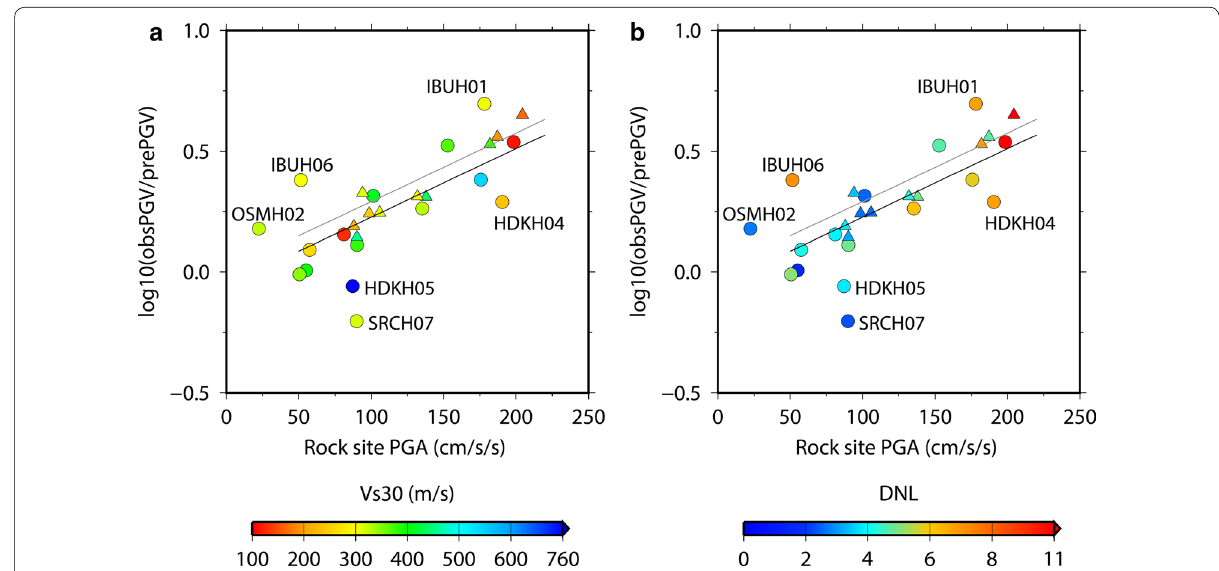
Fig. 16 Plots of logarithmic residuals for PGVs as a function of rock site PGAs using the GMPEs in Si and Midorikawa (1999). The data are color-coded by Vs30 values in a and DNL values in b , respectively. The KiK-net and K-NET sites are indicated by circles and triangles, respectively. The gray and solid lines denote the correction values for PGVs as a function of PGAs at rock sites using Eq. 3 for Vs30 values of 150 and 450 m/s, respectively. Note that the data points having DNL values smaller than 4 were excluded in the derivation of Eq. 3; they are included in the above plots for reference only. Some data points are provided with their site codes for reference close to the data